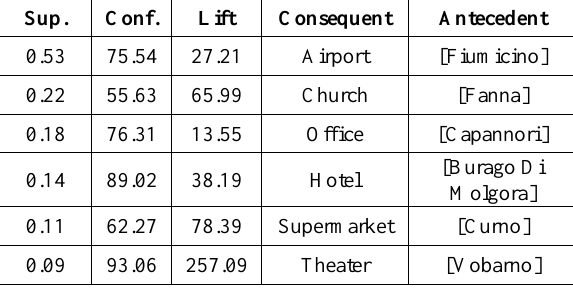
Table 4. A number of mined rules which relate a specific functionality to each